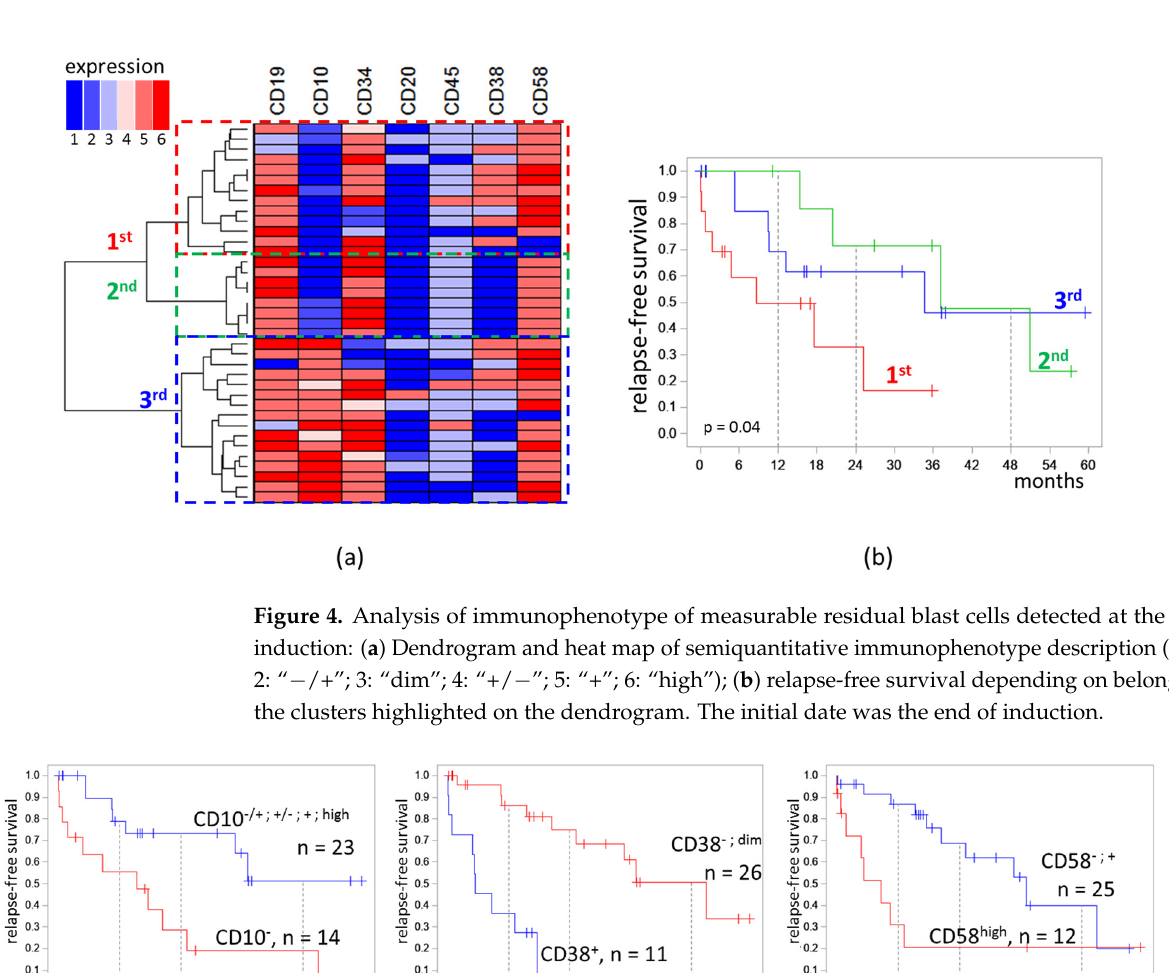
Figure 4. Analysis of immunophenotype of measurable residual blast cells detected at the end of induction: ( a ) Dendrogram and heat map of semiquantitative immunophenotype description (1: “ − ”; 2: “ − /+”; 3: “dim”; 4: “+/ − ”; 5: “+”; 6: “high”); ( b ) relapse-free survival depending on belonging to the clusters highlighted on the dendrogram. The initial date was the end of induction.